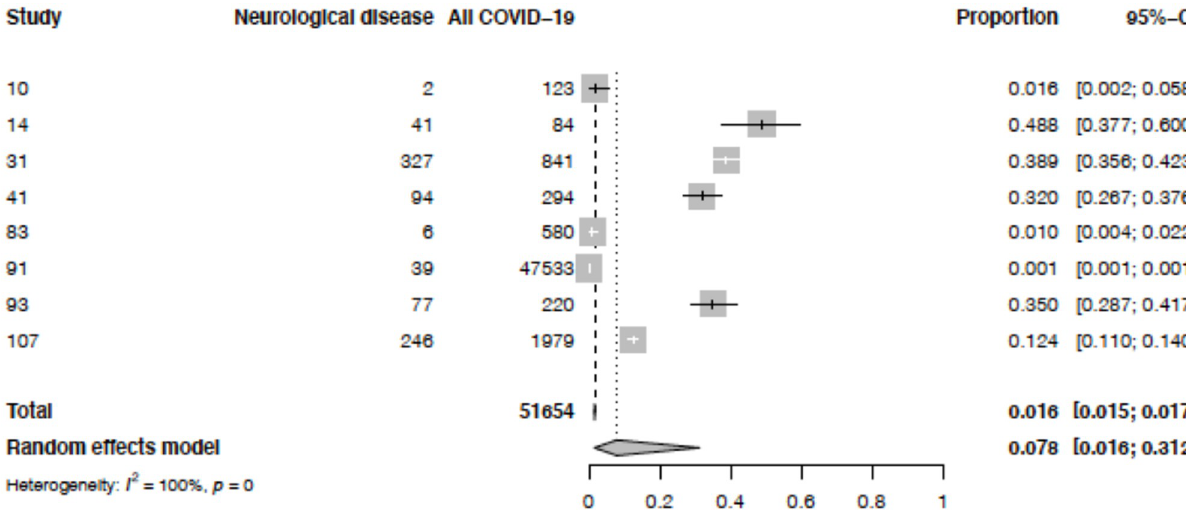
Fig 5. Pooled proportions of all patients hospitalised with COVID-19 reported to have acute new-onset neurological disease. Neurological disease = number of patients with neurological COVID-19 disease. All COVID-19 = number of patients with all COVID-19 disease hospitalised in the same centre over the same time